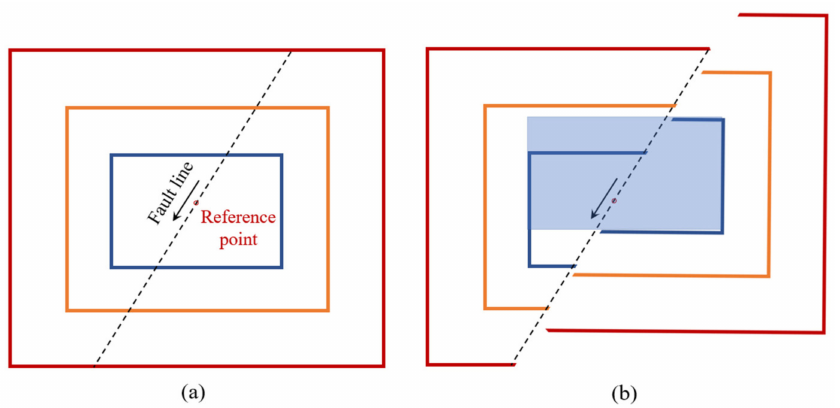
Figure A7. Fault generation illustration. ( a ) Model before fault displacement with the fault line and reference point. ( b ) Generated fault